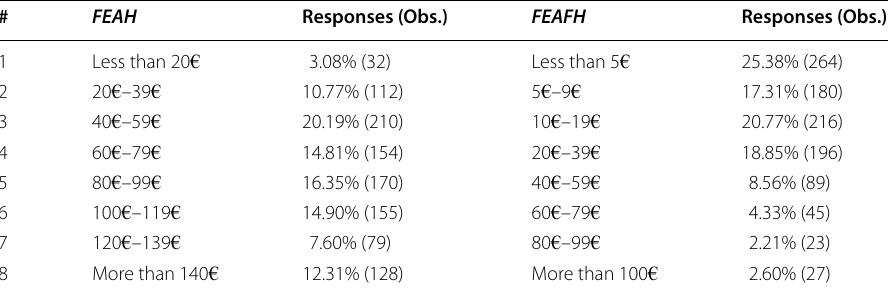
Table 2 Summary of food expenditure ordinal